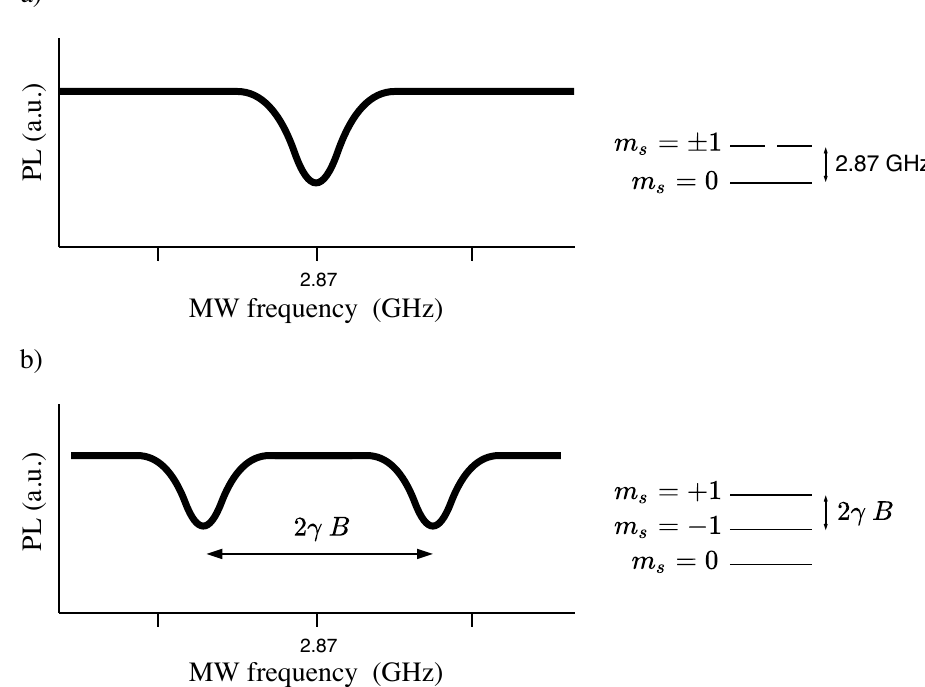
Figure 7. Observed dip for a bulk sample in the direction of the magnetic field in the crystallographic direction (other directions are also present but not represented in this case) of the photoluminescence at the resonance frequency ( a ) and split of the degenerated state because of the Zeeman effect ( b